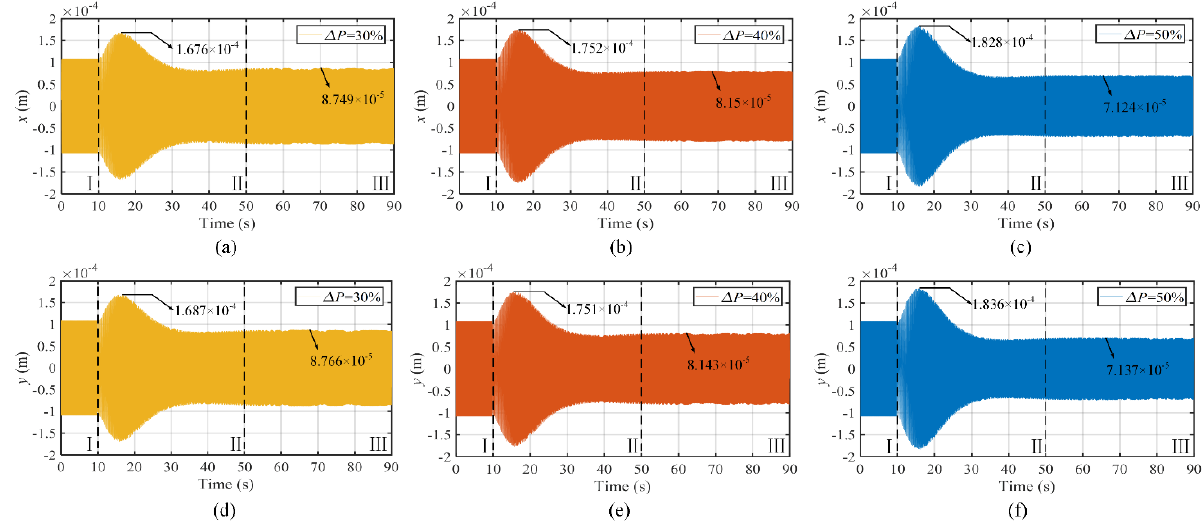
Figure 10. The time-domain figure of the hydro-turbine runner under different sudden load increasing amounts. ( a – c ) In x -direction; ( d – f ) in y -direction.